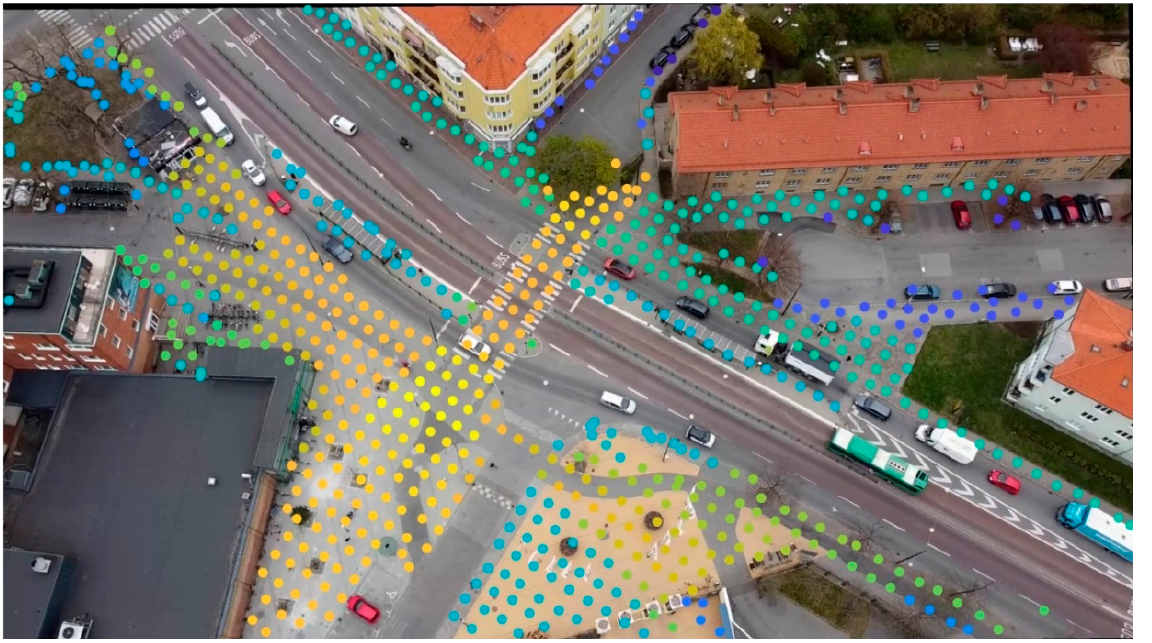
Figure 4. Integration map of Folkets Park showing low/good integration values in yellow and high/bad integration values in blue. Polygon map of Folkets Park, Malmö.